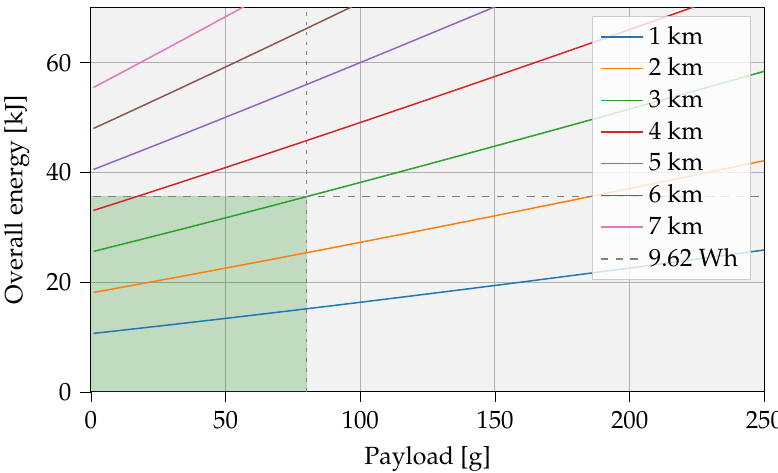
Figure 14. UAV energy needs for varying payloads and servicing distances. Delineated in green are the practically feasible cases, due to battery energy and payload limits. Assuming one UAV battery (9.62Wh), the payload can be as high as